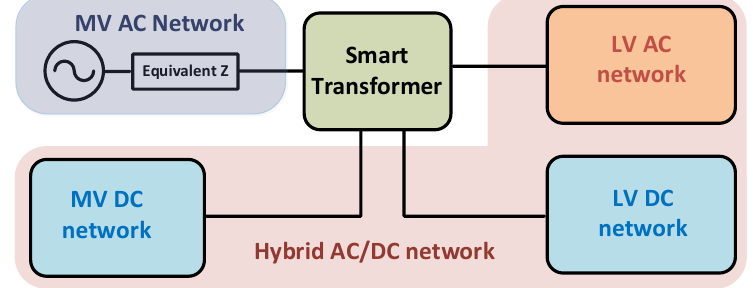
Figure 1. Overall structure of the complete computational